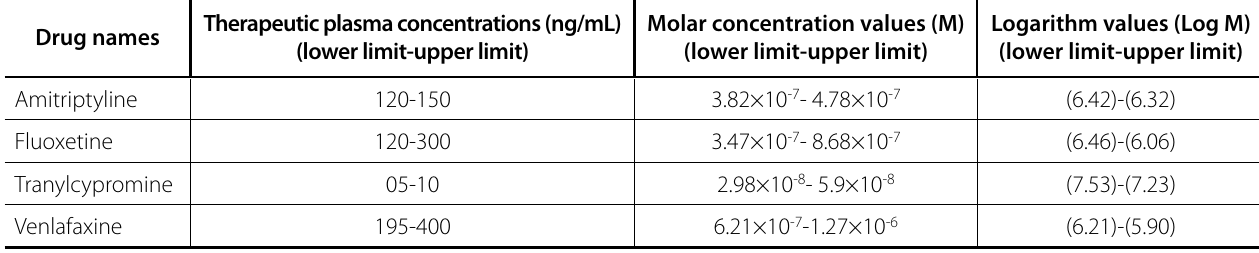
Table 1 . Drug names, therapeutic plasma concentrations (lower limit-upper limit), molar concentration values and -logarithm values corresponding to molar concentration